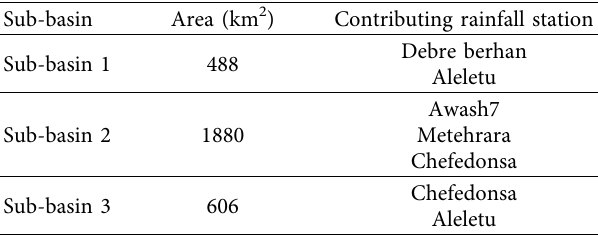
Table 1: Kesem watershed sub-basins, area, and rainfall